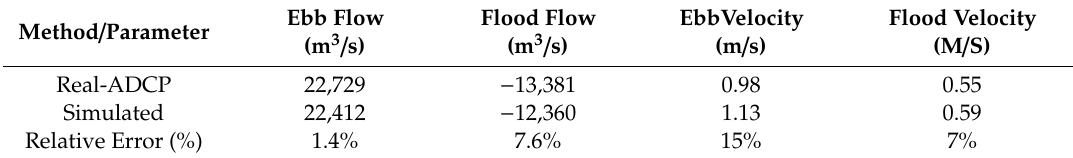
Table 3. Comparative table between CSA data simulated and measured in the field.